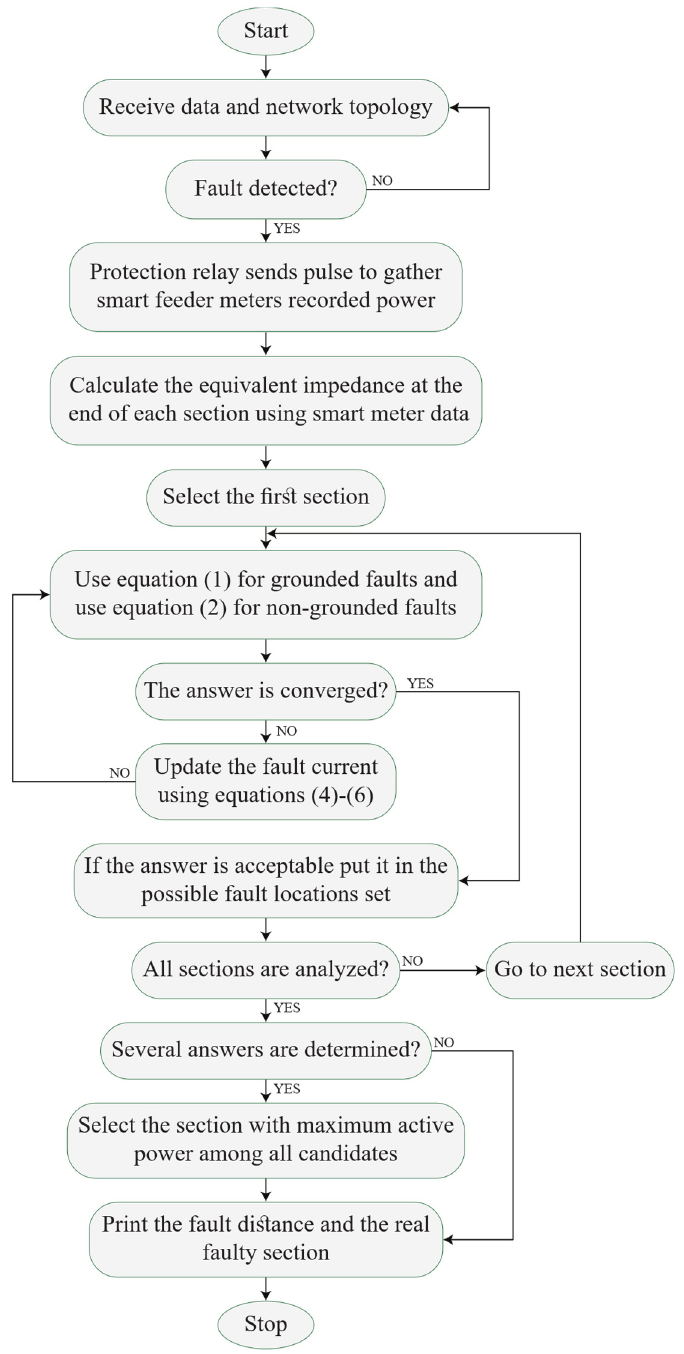
Figure 4. Flow-chart of the proposed